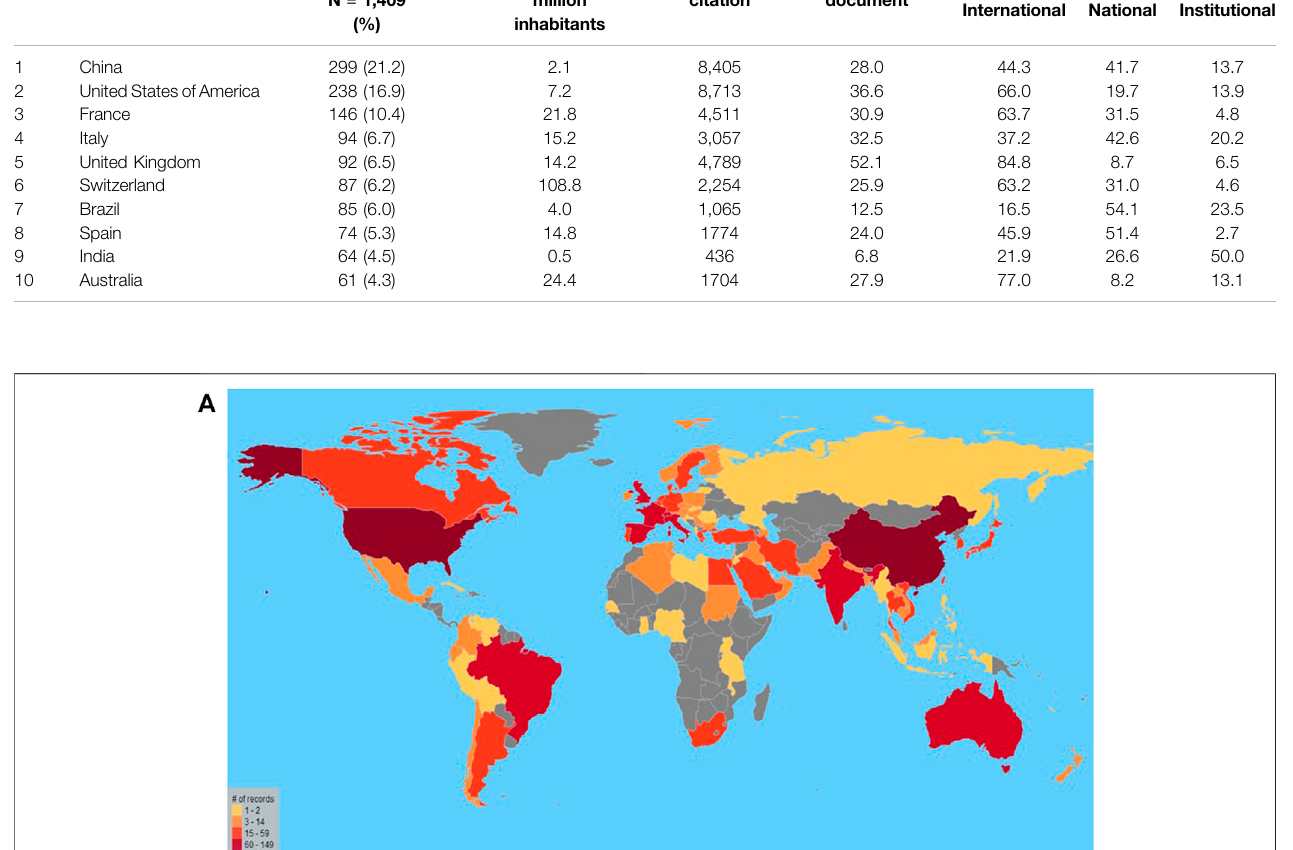
the number of publications of the country and the thickness of lines is in correlation with the size of collaboration between the countries.